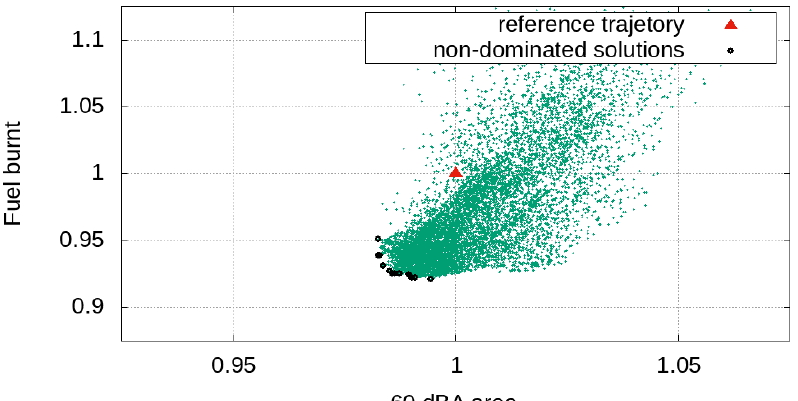
Figure 7. Approach manoeuvre for the single-aisle aircraft: normalised DPSO solutions with reference trajectory and approximated Pareto